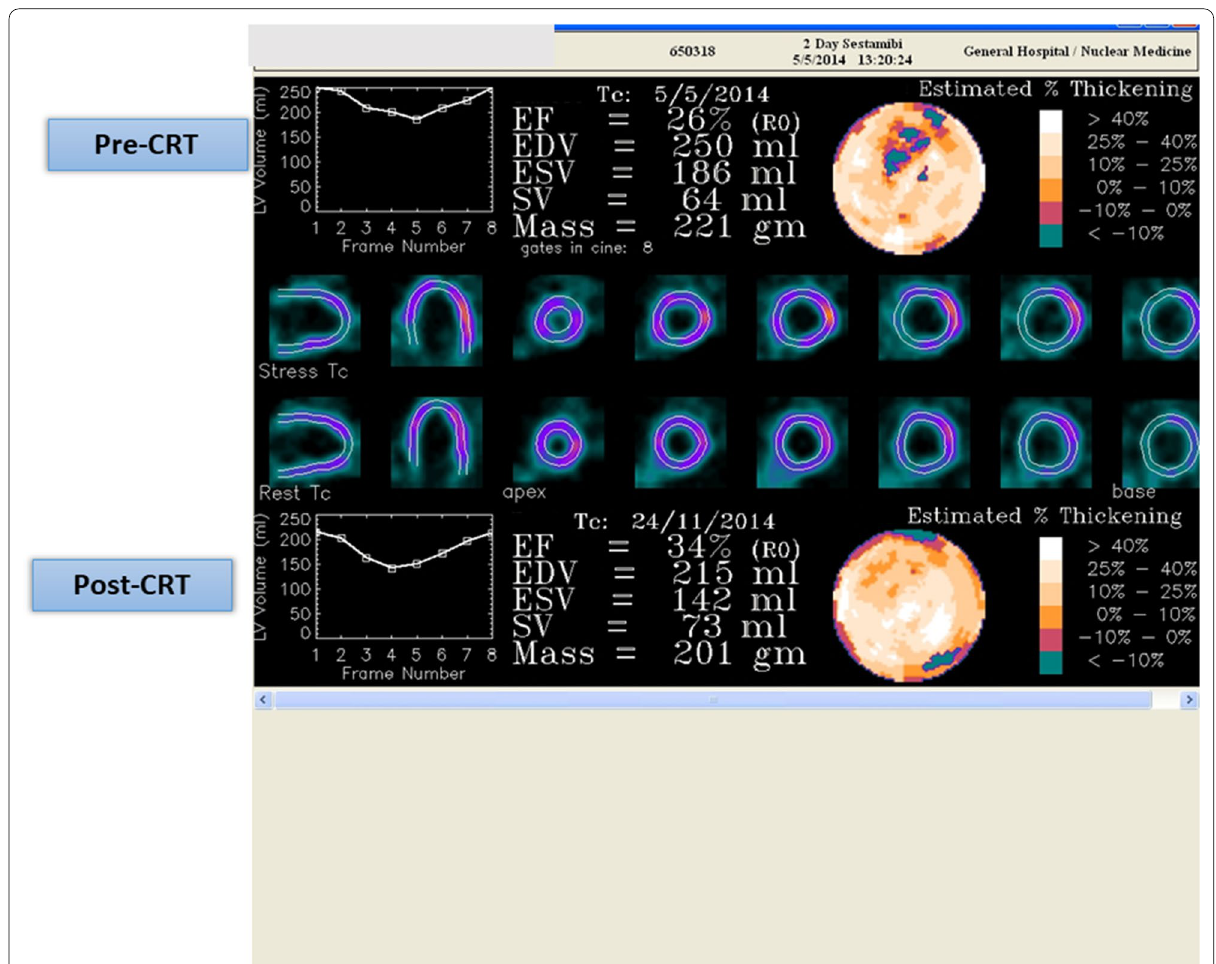
Fig. 2 Same patient, ventricular function behavior comparing pre- and post-CRT. There is a functional improvement post-CRT (LVEF increase and ventricular volumes reduction). CRT cardiac resynchronization therapy, EF ejection fraction, EDV end-diastolic volume, ESV end-systolic volume, SV stroke